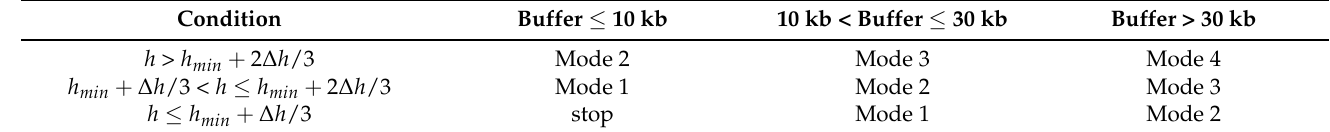
Table 6. Combination AMC.